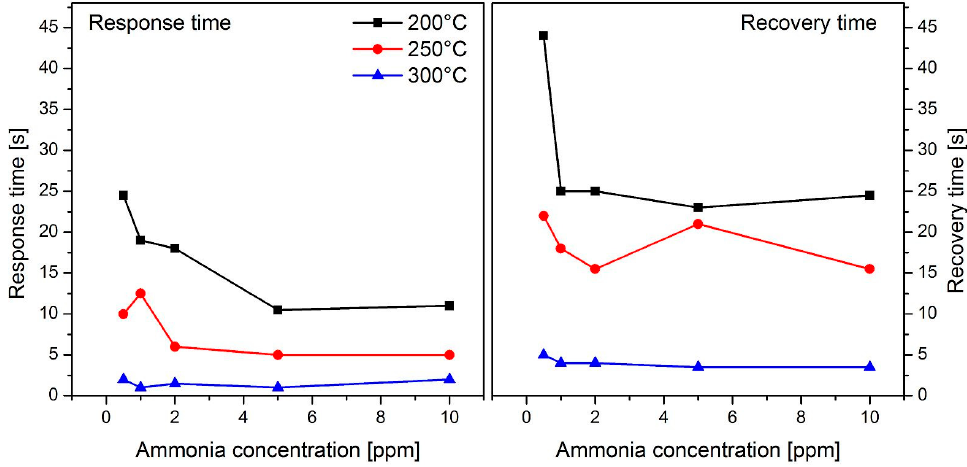
Figure 5. Response times ( left ) and recovery times ( right ) as a function of the ammonia concentration for three working temperatures.